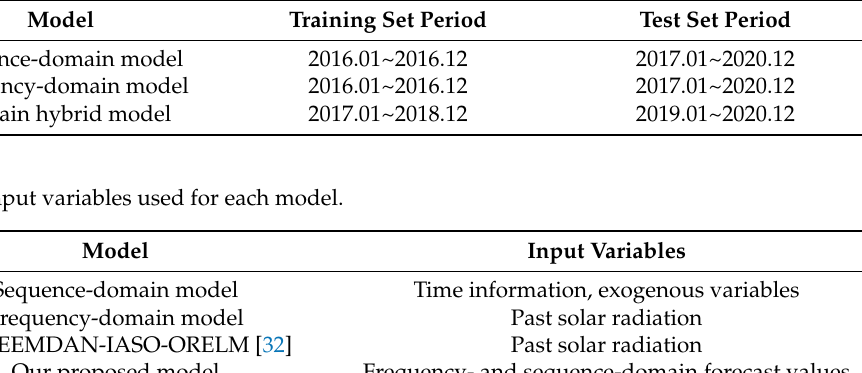
Table 3. Period of data used for the training and testing of the forecasting model.